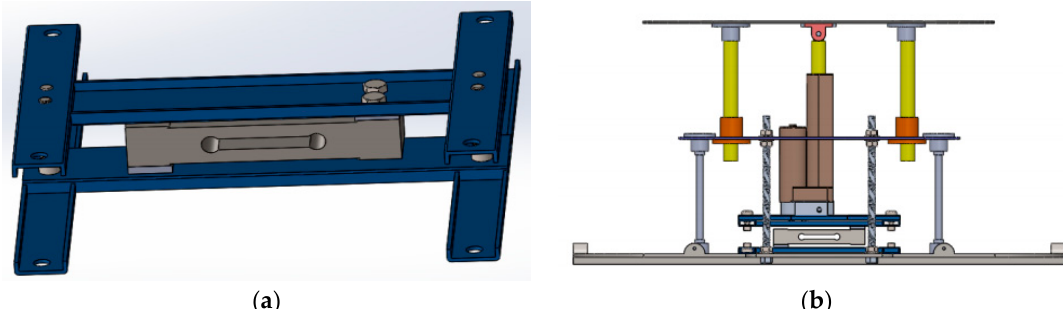
Figure 16. Design of attaching mechanism for load cell ( a ) and loading actuator ( b ).